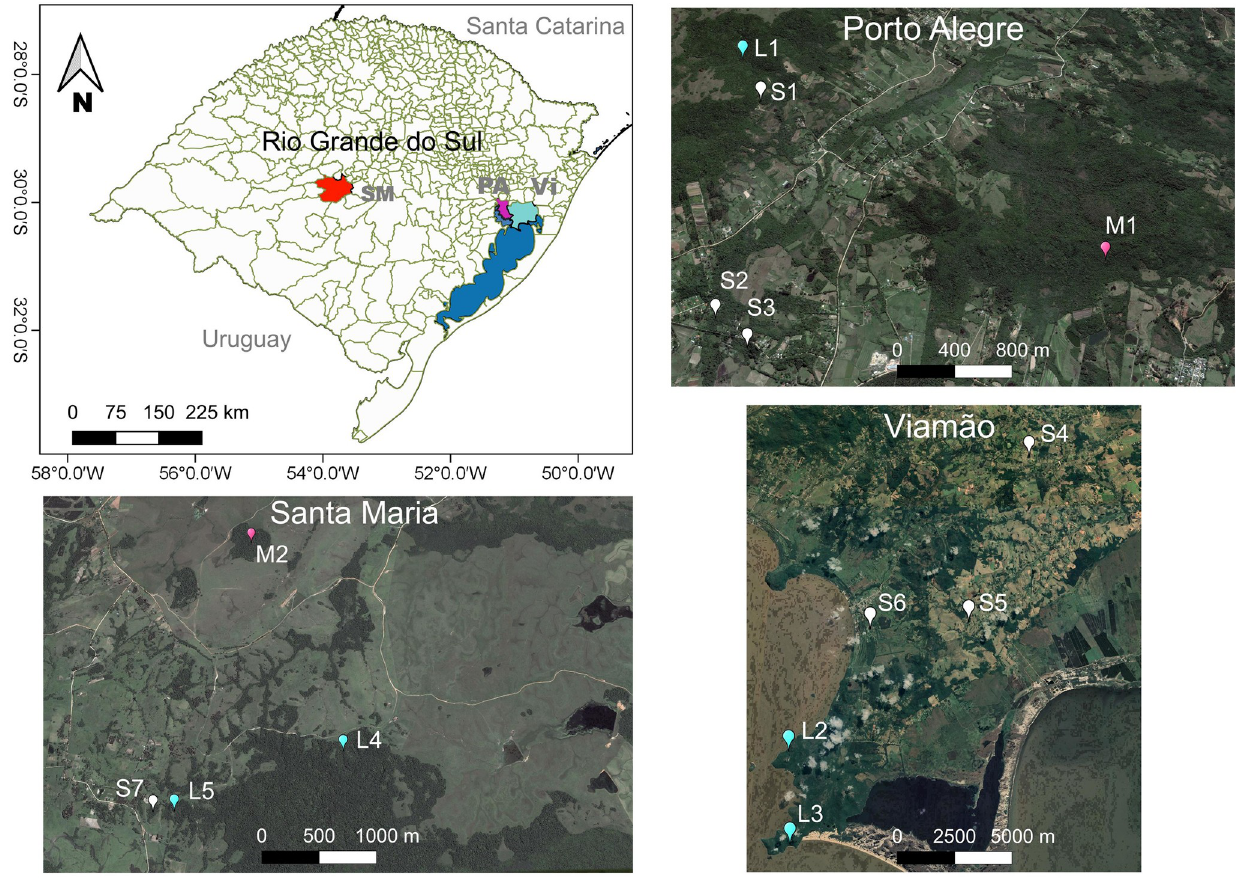
Fig 1. Location of the 14 study sites in the municipalities of Santa Maria (SM, red polygon), Porto Alegre (PA, purple polygon), and Viam ã o (Vi, cyan polygon), southern Brazil. Color markers indicate the exact location of the small (white), medium (rose), and large (cyan) Atlantic forest fragments inhabited by the study groups. Lansat7 open-access images (available at http://earthexplorer.usgs.gov/) from 2008 for SM and 2013 for PA and Vi.